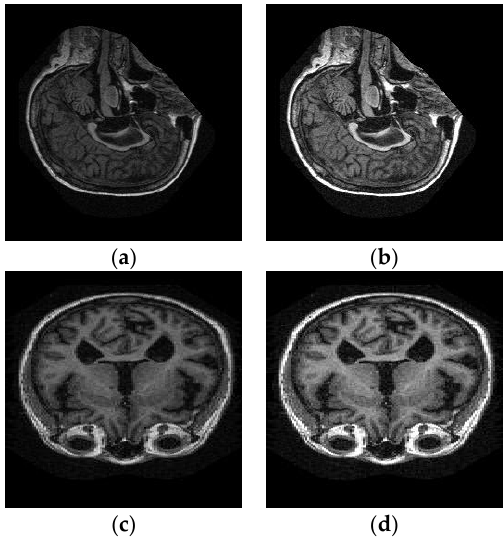
Figure 3. ( a , c ) Input MRI scans. ( b , d ) Contrast Stretched output Images. Sensors 2019 , 19 , 2645